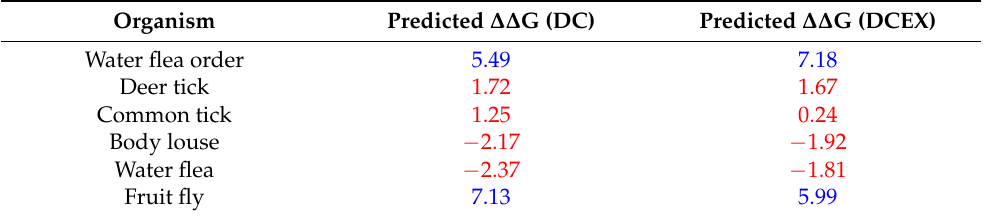
Table 6. Predicted ∆∆ G values of SARS-CoV-2 N501Y S-protein: ectoparasite ACE complexes for direct contact (DC) residues and also for direct contact plus extended (DCEX) residues. Ectoparasites are categorised according to risk of infection by SARS-CoV-2, with ∆∆ G ≤ 3.72 being at risk (red), and ∆∆ G > 3.72 not at risk